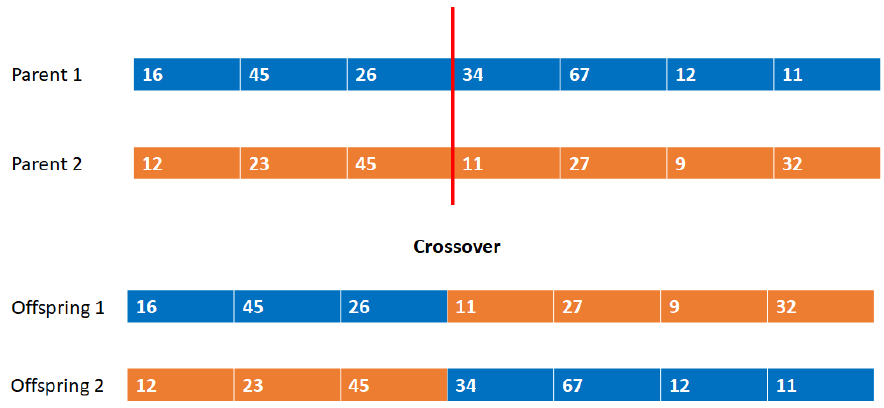
Figure 1. Basic principle of the crossover operator in GA.